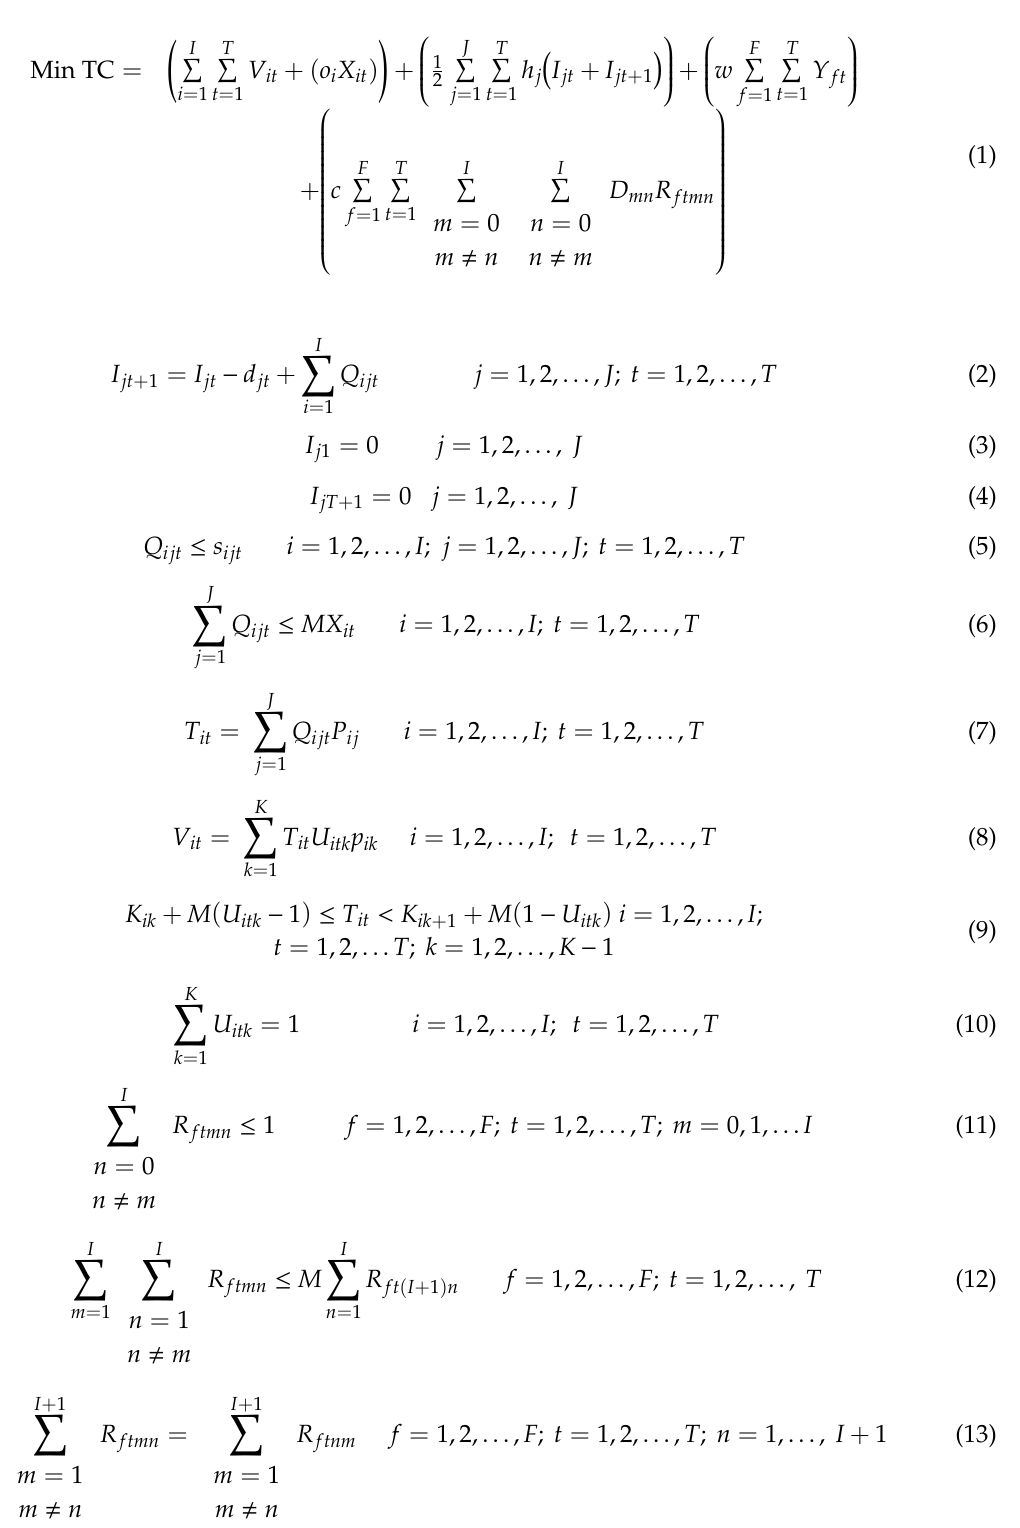
w : fixed cost of a vehicle per time period (unit of currency / period) b f : maximum loading capacity in weight for vehicle f (weight unit) u j : unit weight of component j (weight unit /